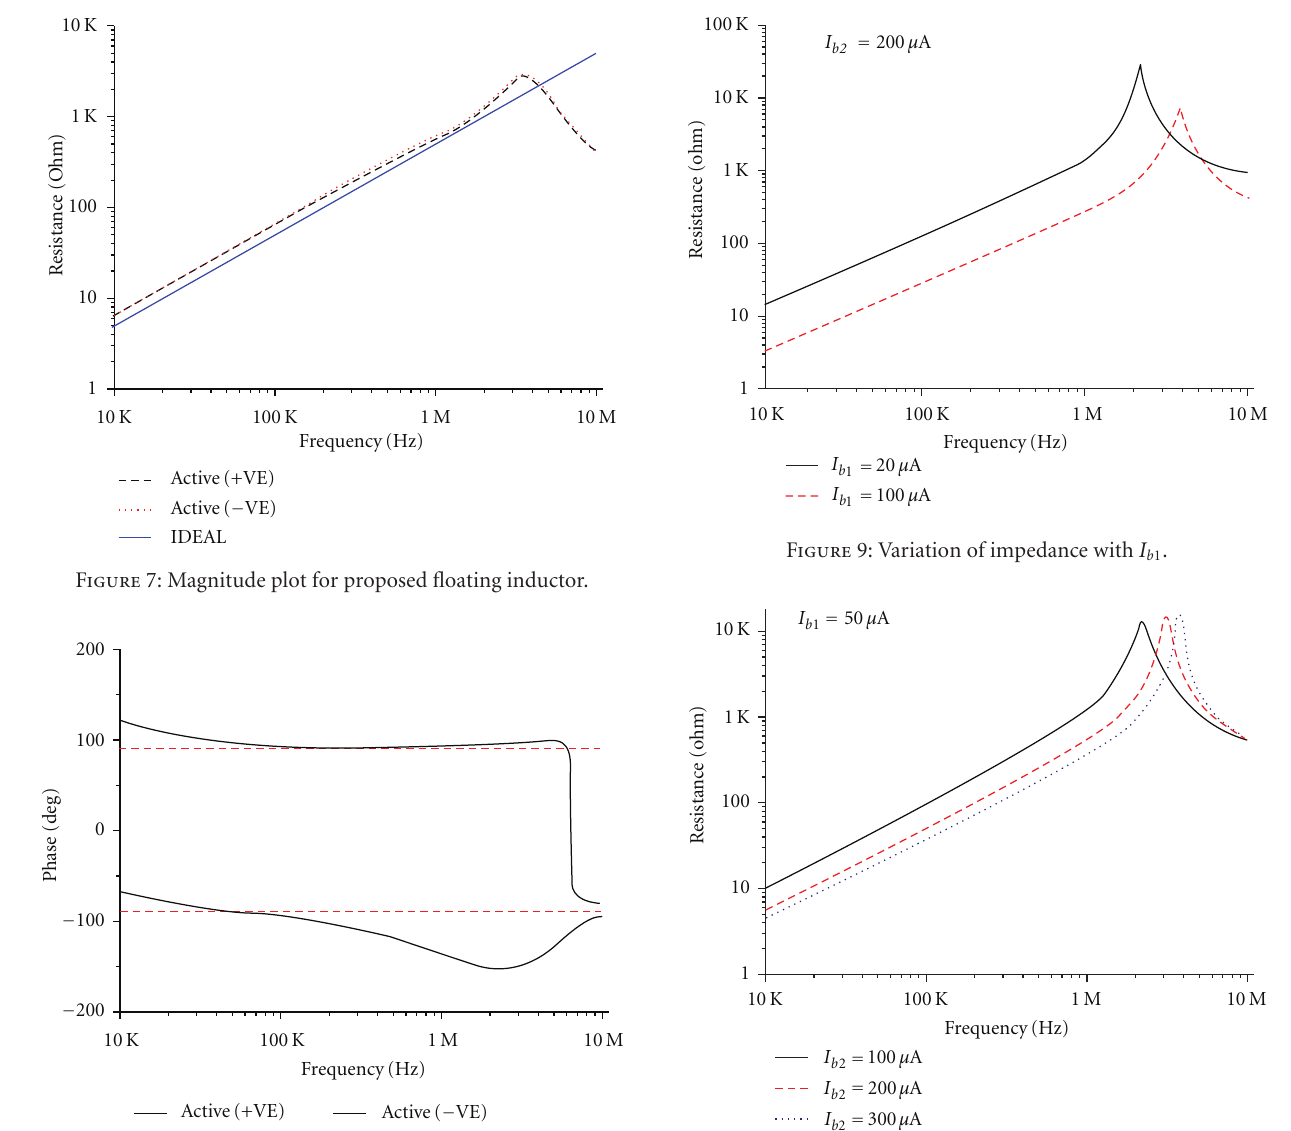
Figure 8: Phase plot for proposed inductor.